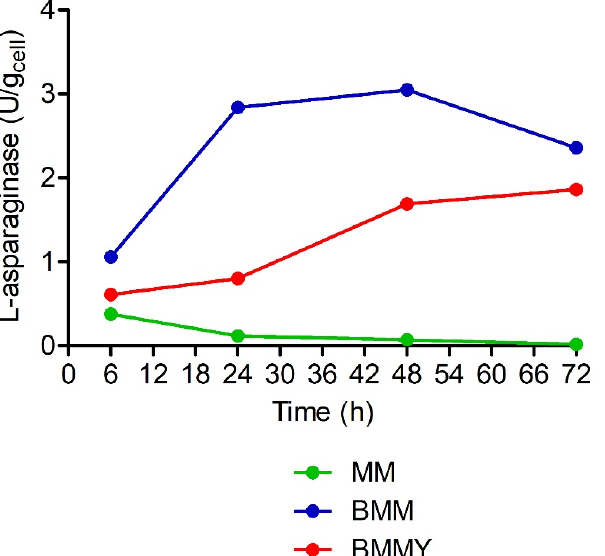
Figure 3. Intracellular L ‐ asparaginase activity of a MUT + clone measured in recombinant K. phaffii X ‐ 33 whole cell suspensions transformed with pPICZ α A vector carrying partial L ‐ asparaginase gene from P. sizovae cultivated in MM, BMM and BMMY expression media under methanol induction, incubated at 30 °C, 275 rpm, for 72 h.